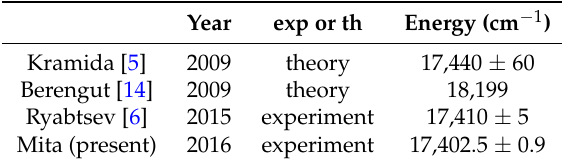
Table 1. Fine structure splitting of the ground term 4 f 13 5 p 6 2 F in W VIII. The uncertainty is not given in the theoretical value for Berengut [14]. The experimental value by Ryabtsev [6] was obtained indirectly through the analysis of EUV